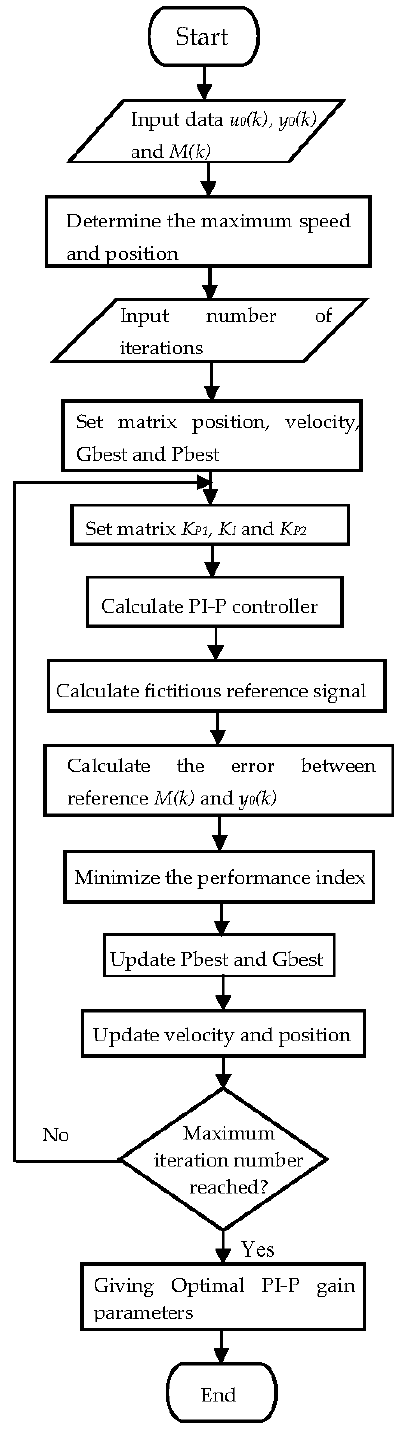
Figure 10. Flowchart of PSO (particle swarm of optimization) algorithm for FRIT.